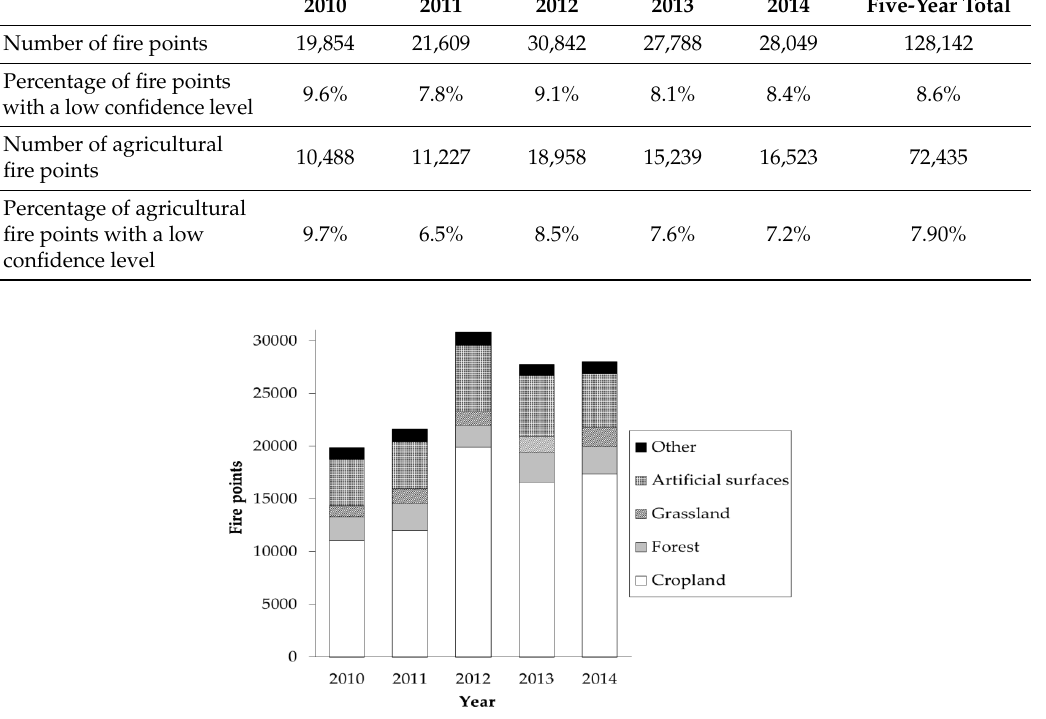
Table 2. The proportion of agricultural fires and fires detected with low confidence levels.